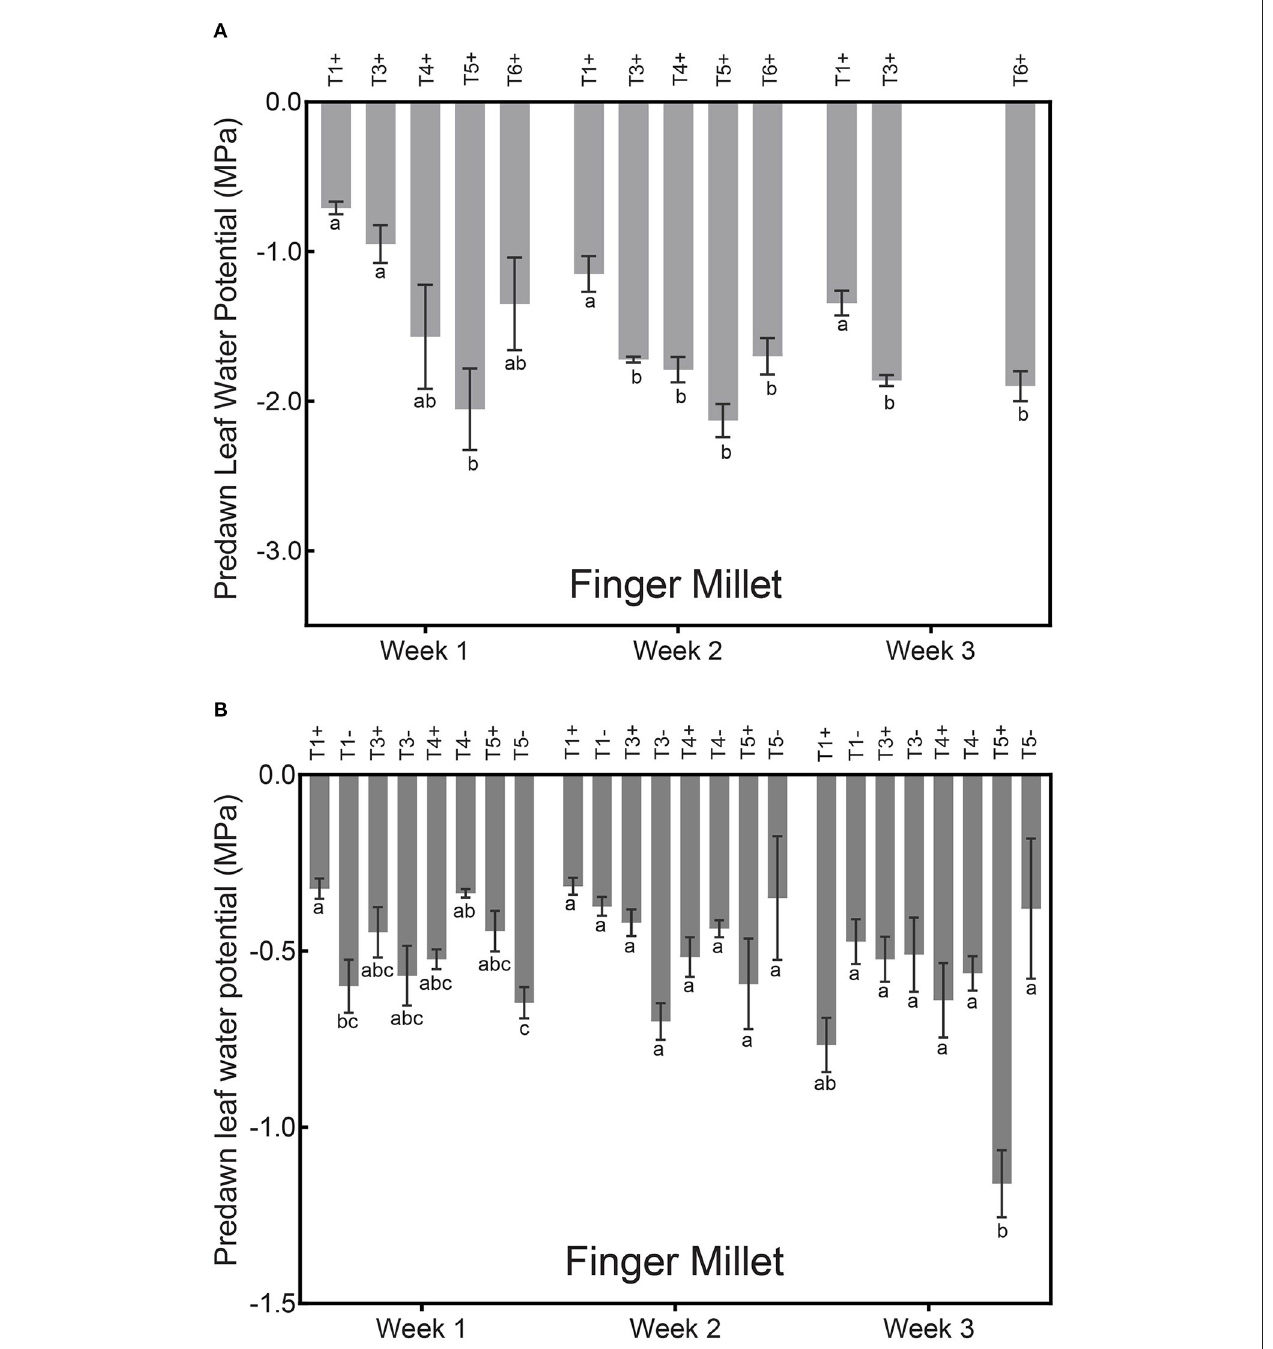
FIGURE 8 | Predawn leaf water potential of FM in different intercropping treatments during the field trials of 2016/17 (A) and 2017/18 (B) at Bengaluru. Weeks represent first, second and third week of November in 2016 and 2017, during which measurement was done. Bars represent the average of four replicates with standard error of mean. Tukey‘s test (One-way ANOVA) was used for multiple comparison and values with same letters are not significantly different from each other at p > 0.05.